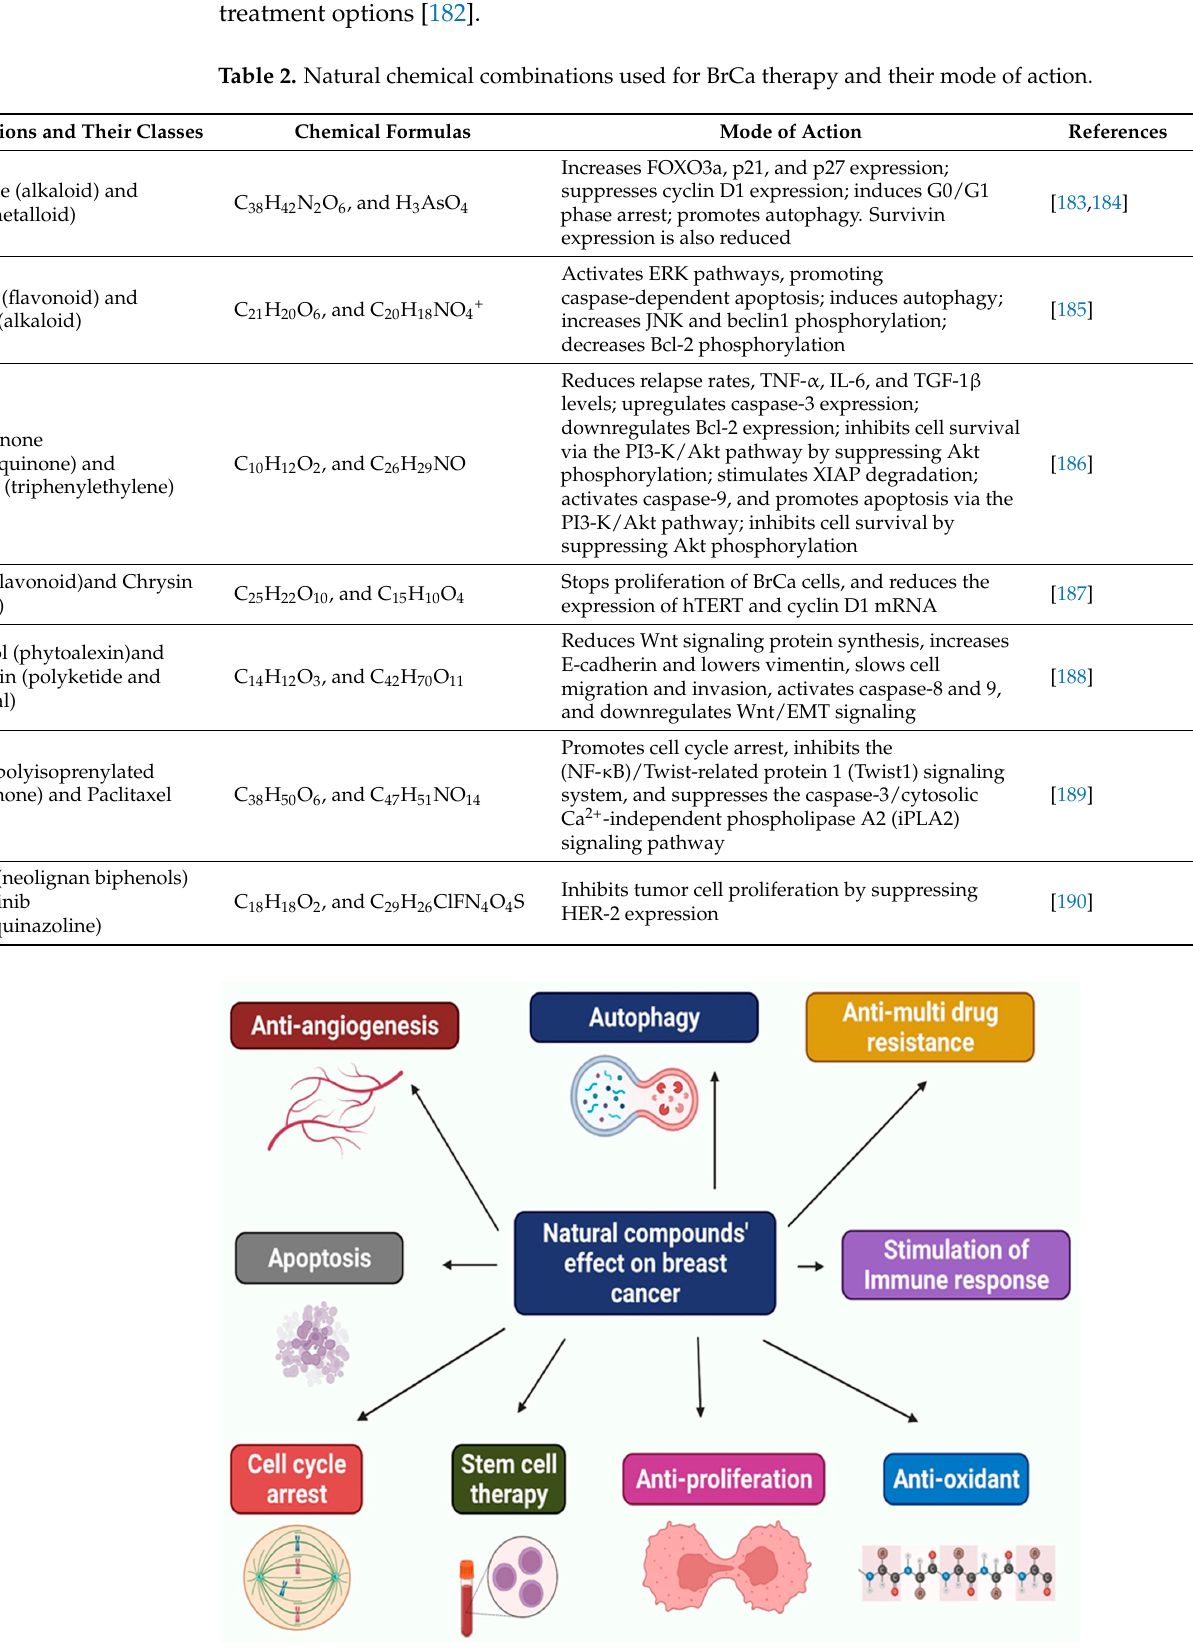
Figure 2. Multifunctional effects of natural compounds on breast cancer. Table 2. Natural chemical combinations used for BrCa therapy and their mode of action.